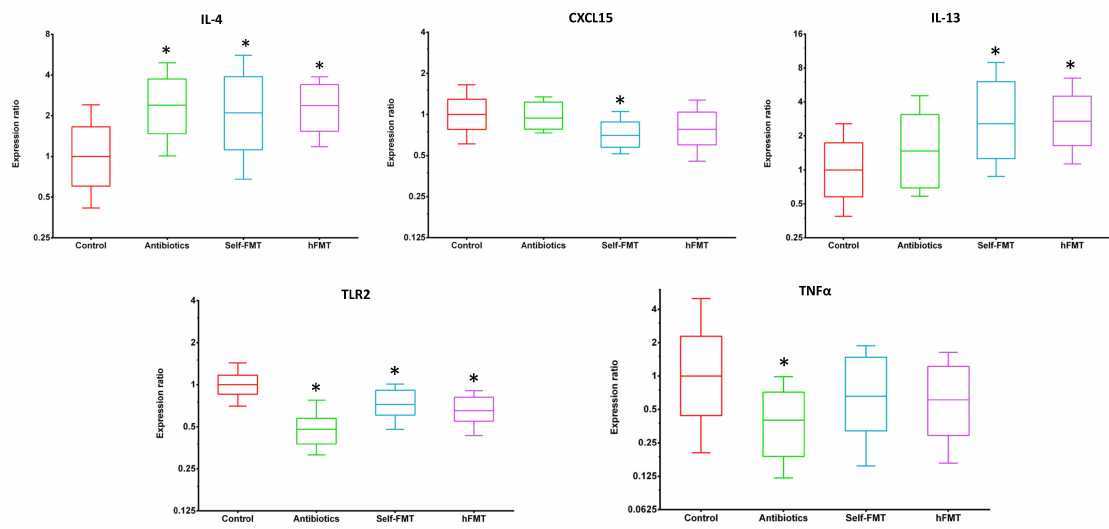
Figure 7. Differences in gene expression in the small intestine of infected mice . Expression of immune system mediators IL4, CXCL15, IL13, TNF α and TLR2 determined by RT-qPCR in mice from the different groups at 7 dpi (n = 5) are shown. The level of significance is indicated relative to the control mice ( p < 0.05) is indicated by an asterisk